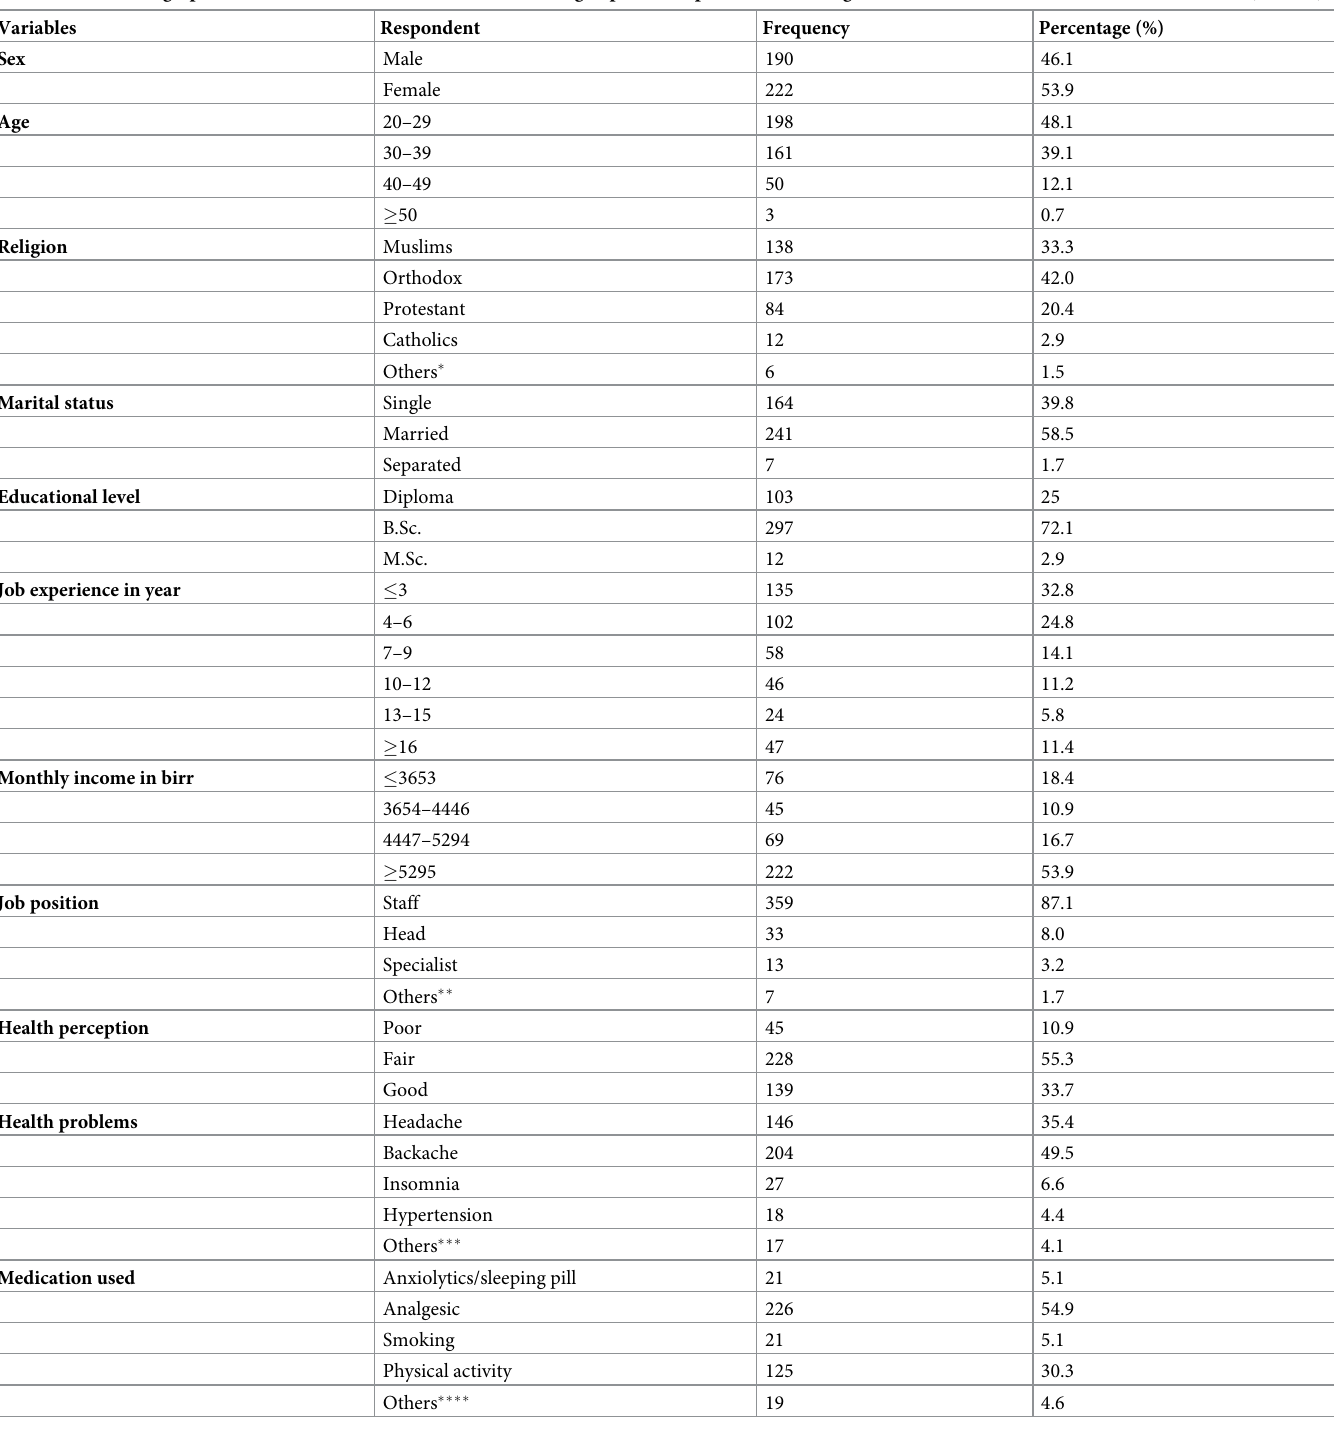
Table 1. Sociodemographic characteristics of nurses who were working in public hospitals of Harari regional state and Dire Dawa administration, 2020 (n =